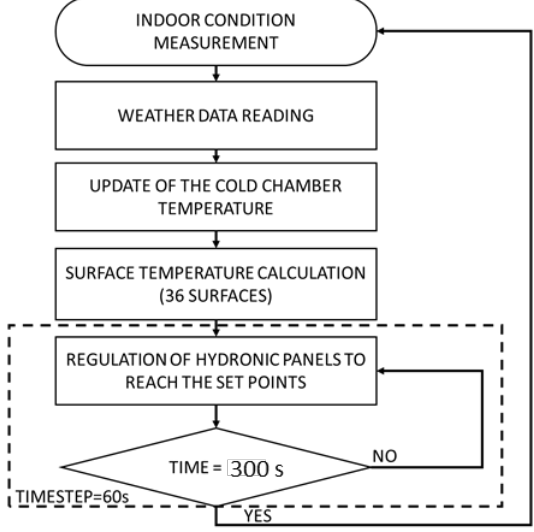
Figure 12. Control process of the experimental facility.